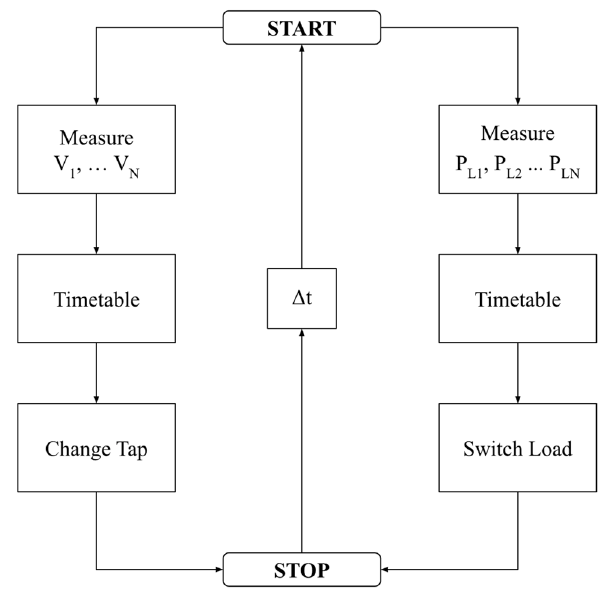
Figure 4. Combined CVR and DLC algorithm flowchart.